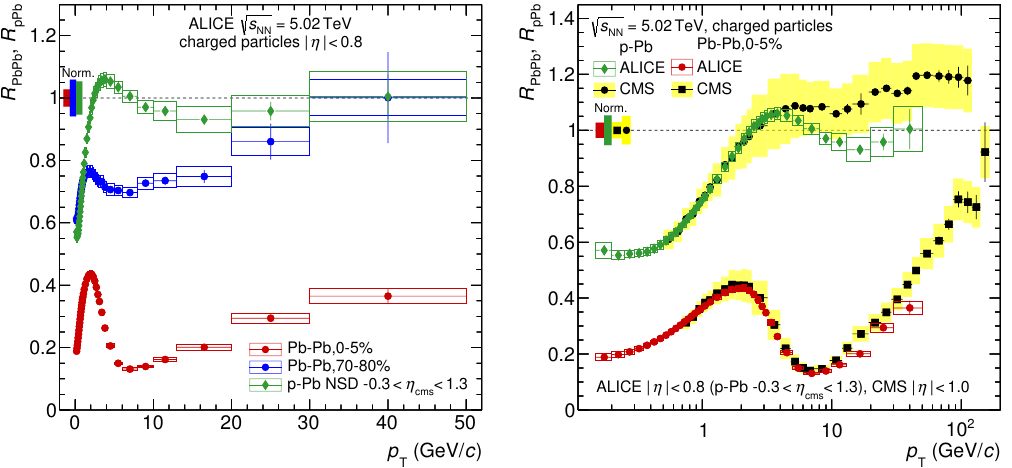
Figure 7 . Left: nuclear modi(cid:12)cation factors measured by ALICE in central (0{5%) and peripheral p (70{80%) Pb-Pb collisions and in p-Pb collisions at s NN = 5 : 02 TeV. Right: a comparison of the nuclear modi(cid:12)cation factors for central (0{5%) Pb-Pb and p-Pb collisions measured by ALICE and CMS [11, 14]. In both (cid:12)gures, the p T -dependent systematic uncertainties are shown as boxes around data points. The normalization uncertainties are shown as boxes around unity.